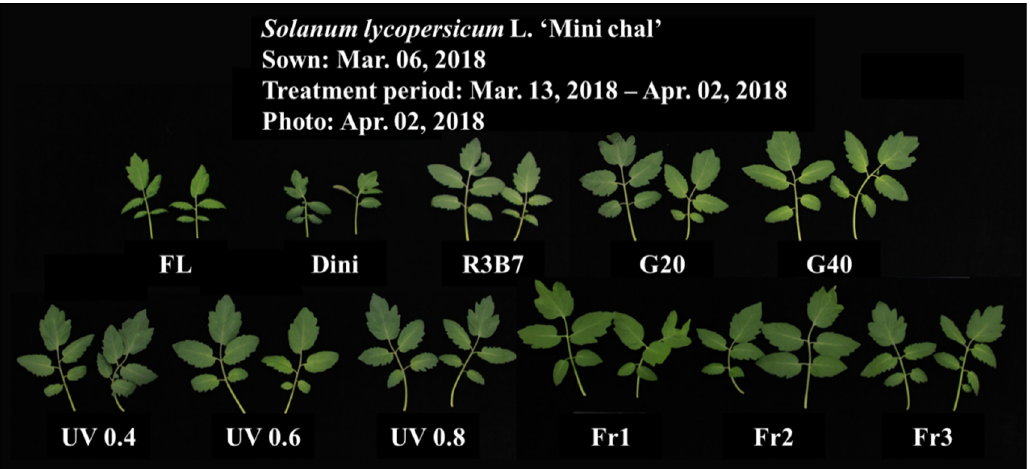
Figure 5. The leaf shapes of ‘Mini Chal’ tomato ( Solanum lycopersicum L.) treated with different light qualities 21 days after start of treatment. Refer to Figure 1 for details on the light quality.